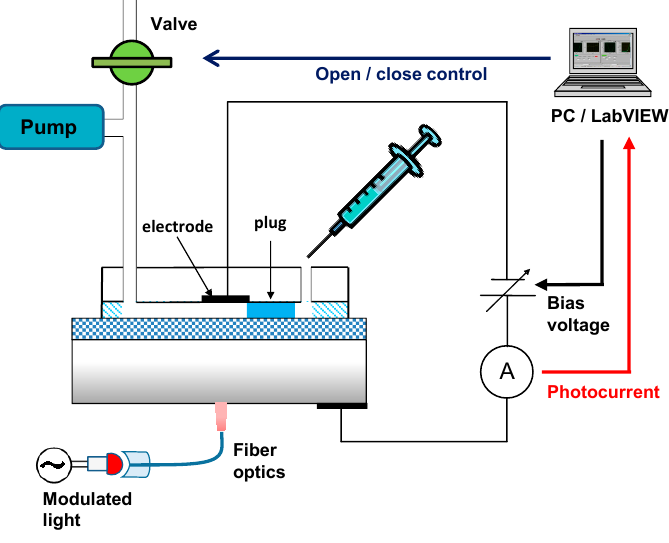
Figure 2. Schematic view of the measurement system.